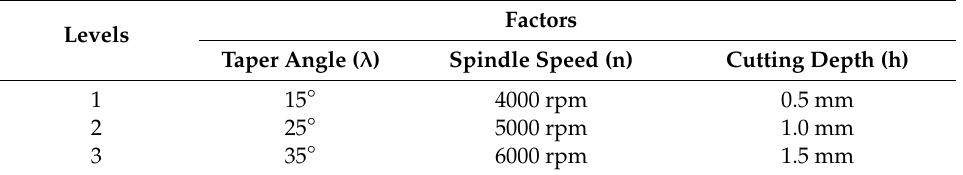
Table 3. Cutting parameters.